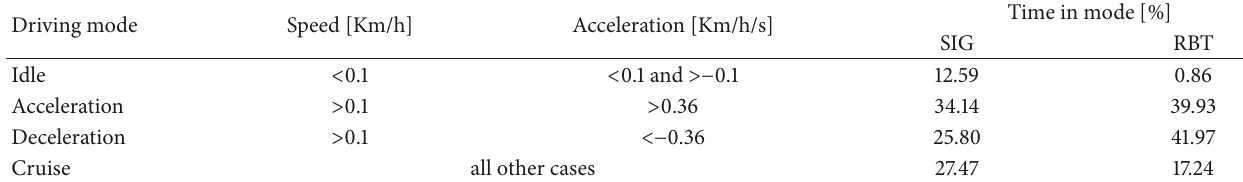
Table 6: Driving mode definition and distribution of trip time among modes for signal and roundabout.